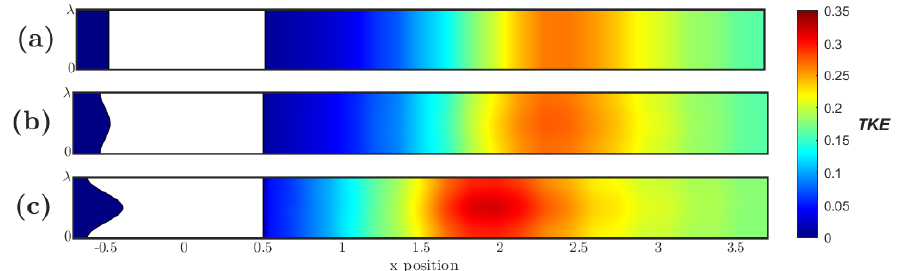
Figure 12. Carpet − like view of mean turbulent kinetic energy in the y = 0 plane: baseline ( a ), A03 ( b ), and A11 ( c ). As a spanwise periodic phenomenon, the spatial average referring to the repetition of wavelengths is calculated and exhibited here as a single wavelength.